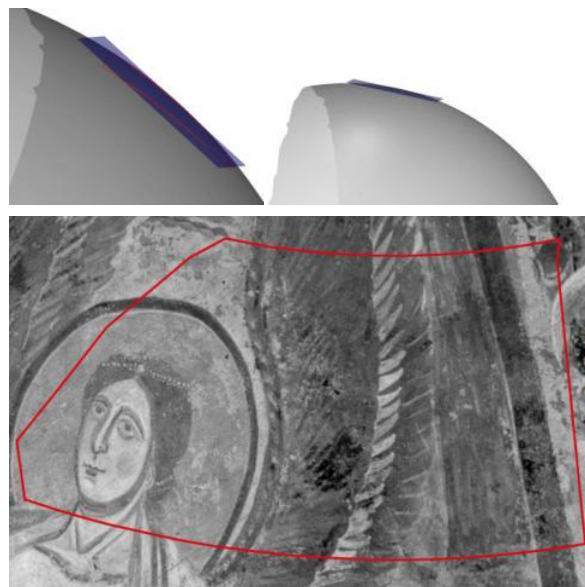
Figure 18. Two views of the extracted planes (above) and orthoprojection of part III (below).